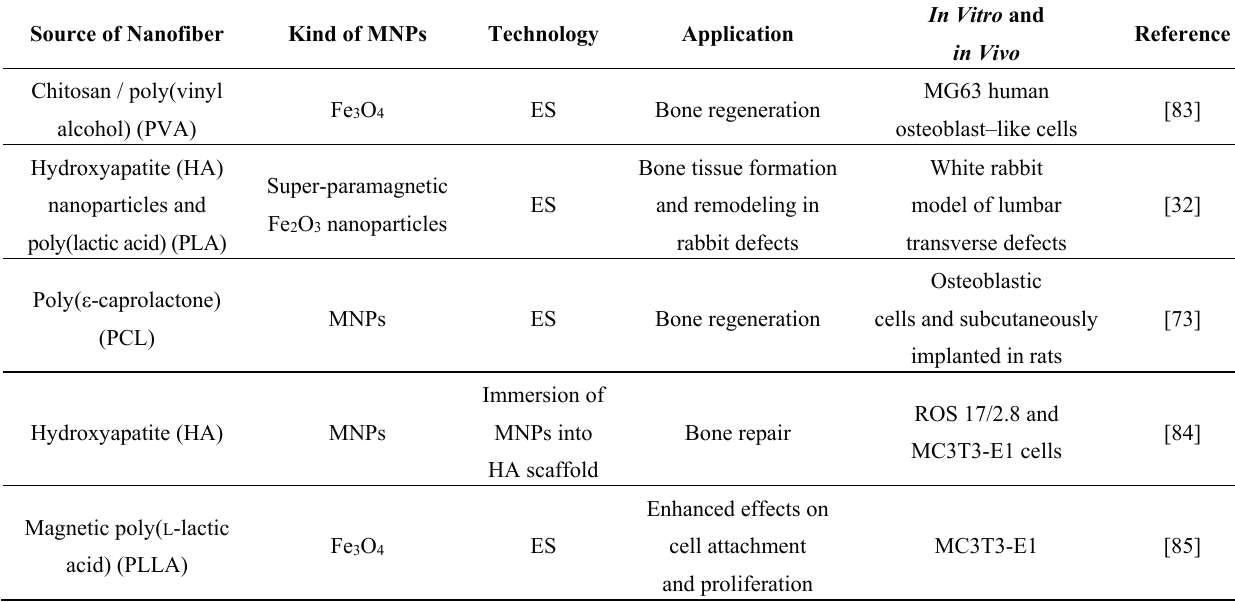
Table 2. Applications of nanofibers loaded with